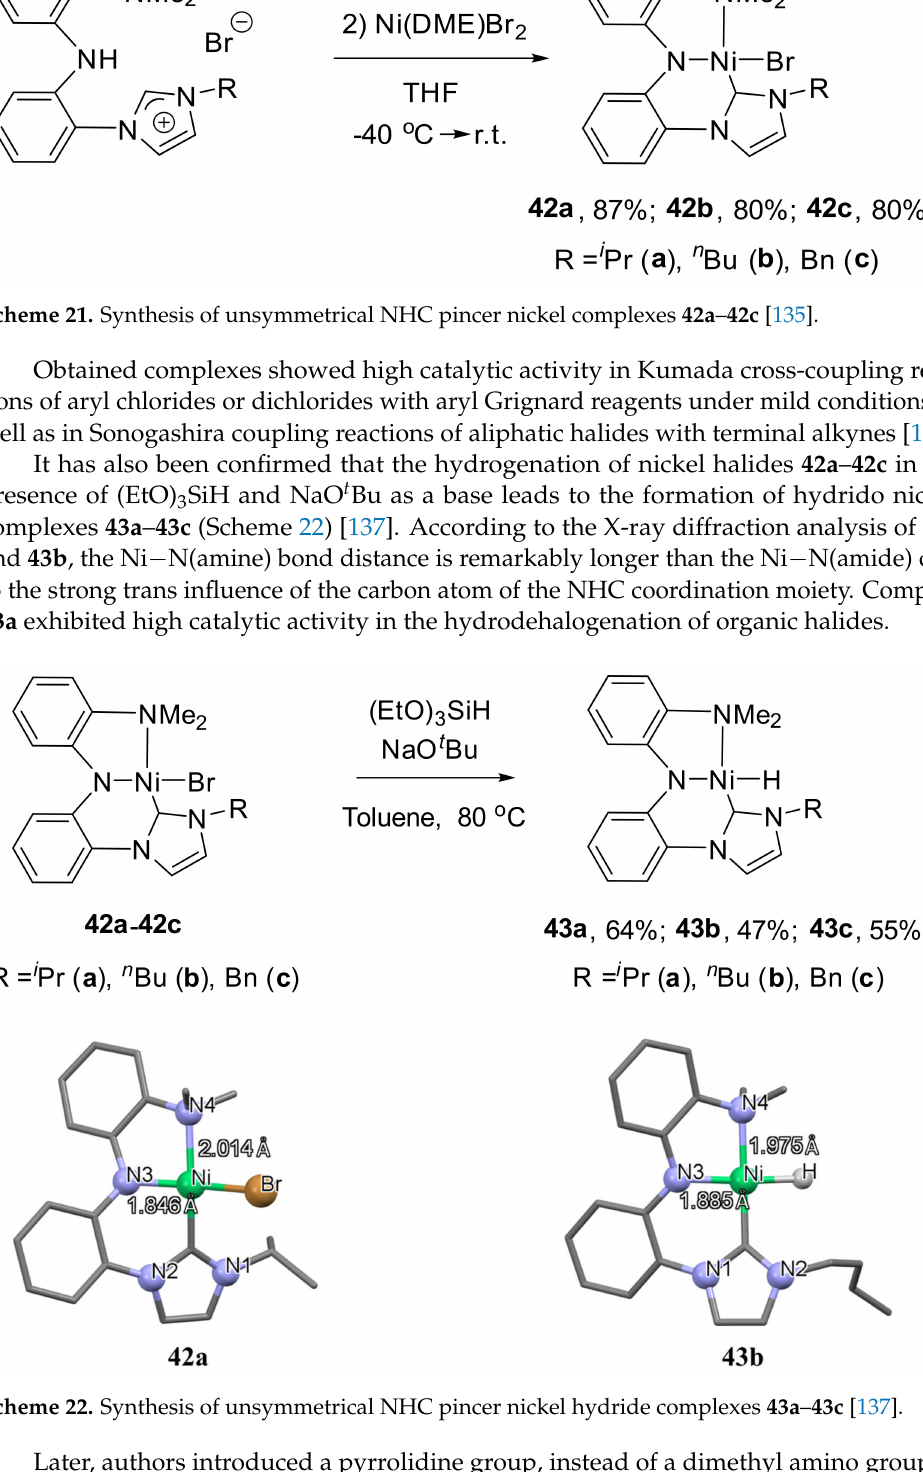
Later, authors introduced a pyrrolidine group, instead of a dimethyl amino group to the pincer ligand structure and synthesized complexes 44a and 44b by the direct cyclomet- alation of the corresponding ligand precursor in the presence of Et 3 N (Scheme 23)